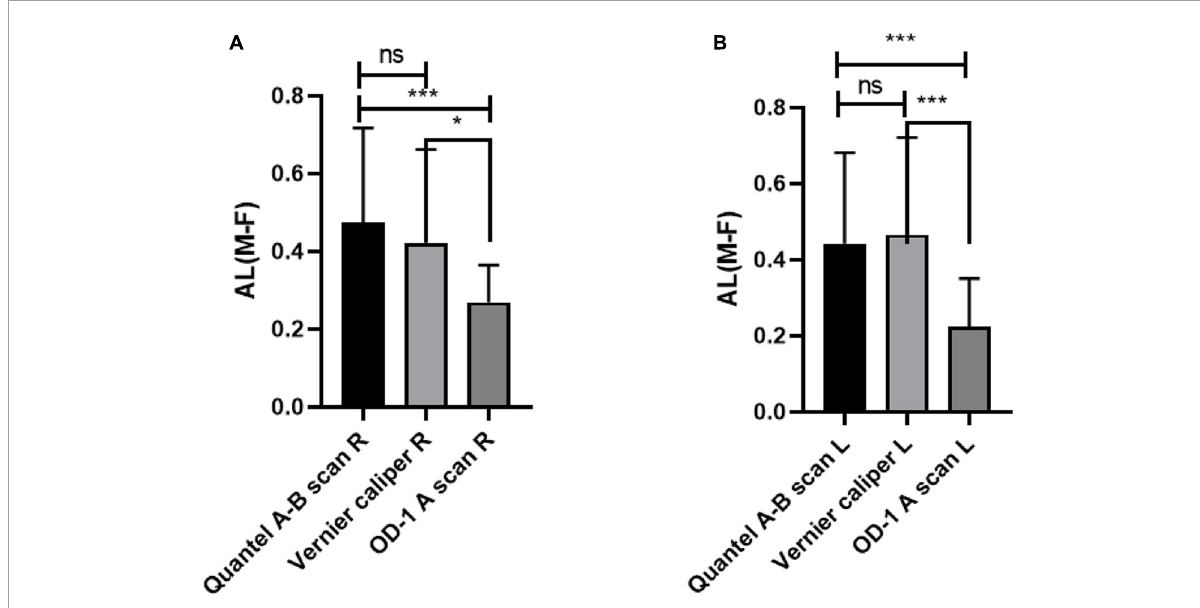
FIGURE4 Comparison of AL difference between male and female rats by three different measurement methods. (A) AL difference in right eye between male and female rats. (B) AL difference in left eye between male and female rats. AL, axial length; R, right eye; L, left eye; M-F, AL difference between male and female rats; ns indicates no statistical significance; * p < 0.05; *** p <